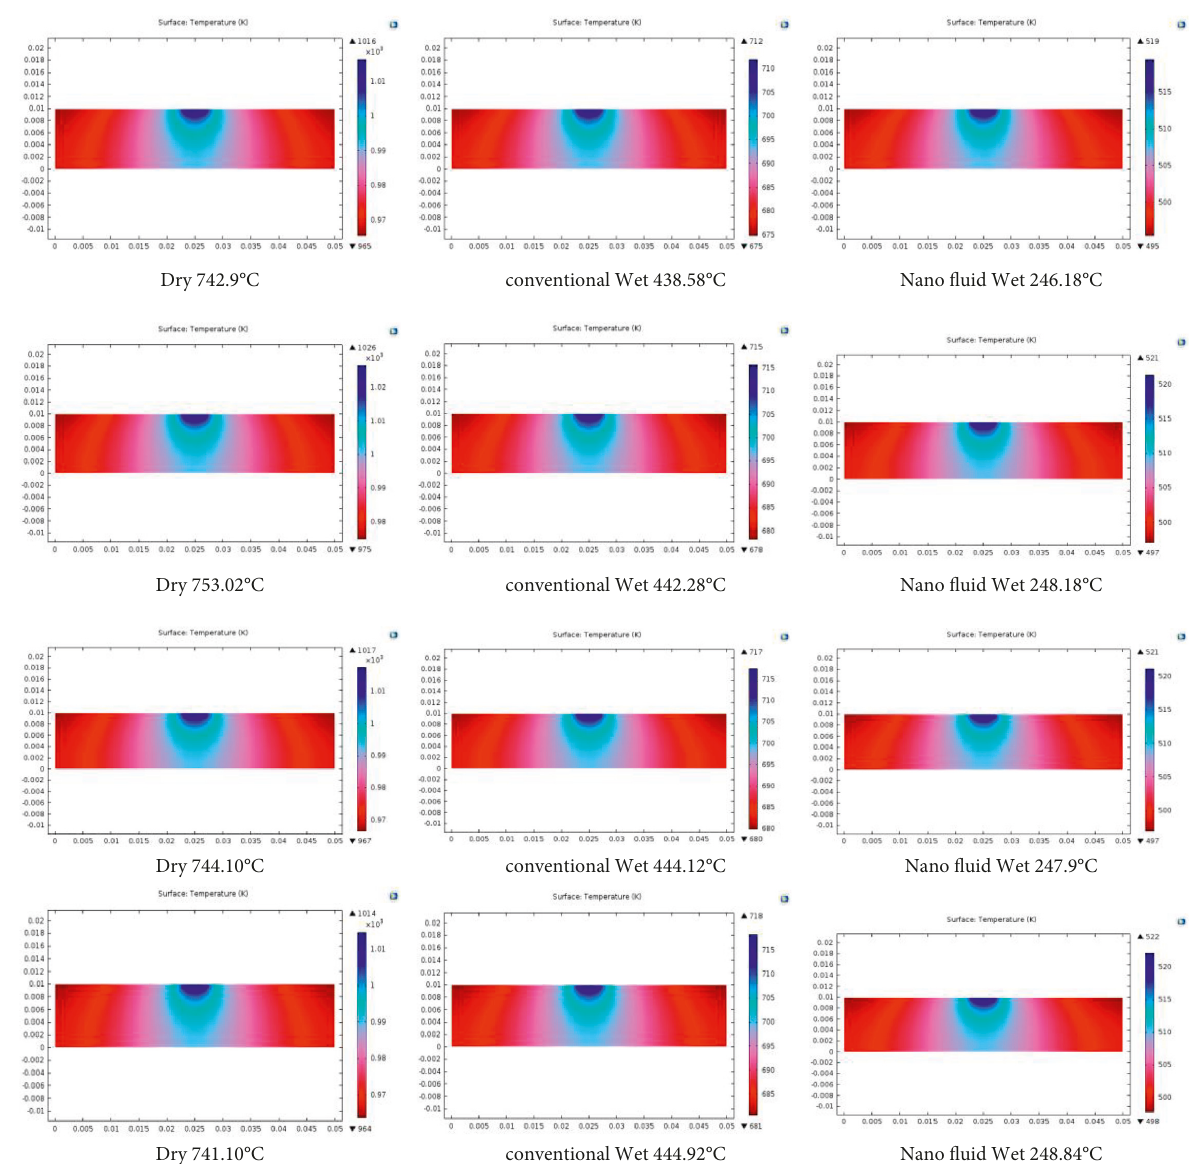
Figure 7: FEM: thermal analysis results. The first column is dry machining, the second column is conventional wet machining, and the third column is nanofluid wet